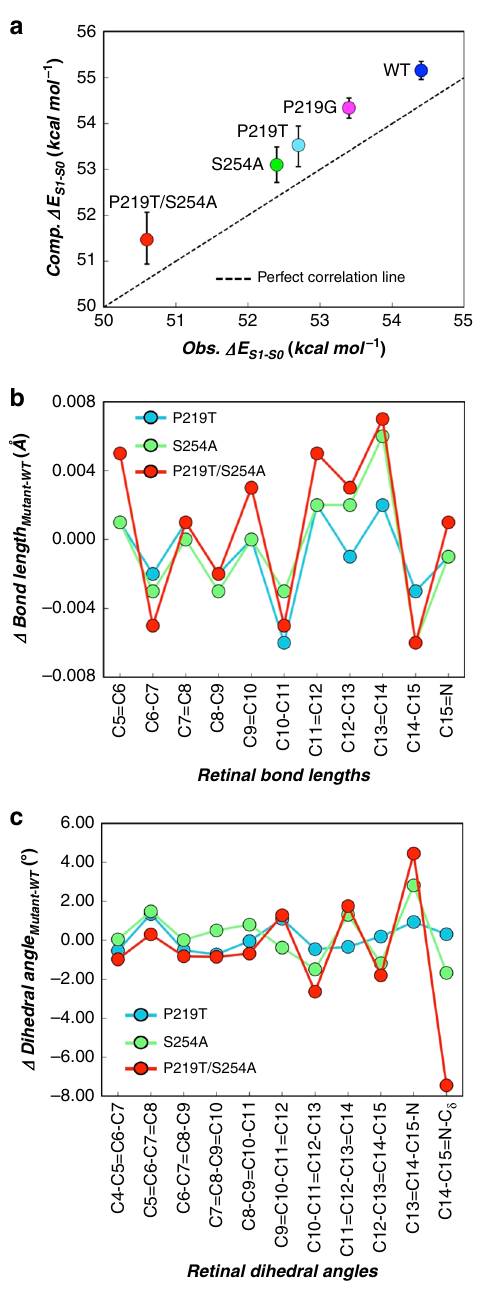
Fig. 5 Excitation energy and conjugated structure of retinal chromophore computed by quantum mechanics/molecular mechanics (QM/MM) models. a Comparison between the computed and observed vertical excitation energies, Δ Ε S1 − S0 (kcal mol − 1 ) of QM/MM models built with ARM protocol at CASPT2//CASSCF(12,12)/6-31G*/AMBER level of theory for KR2 wildtype (WT) (dark blue), P219G (pink), P219T (clear blue), S254A (green), and P219T/S254A (red) mutants. The error bars of the standard deviation are shown in black (see details in Supplementary Table 1). b Bond lengths and c chromophore dihedral angle differences of each mutant relative to KR2 WT at CASSCF(12,12)/6-31G*/AMBER level of